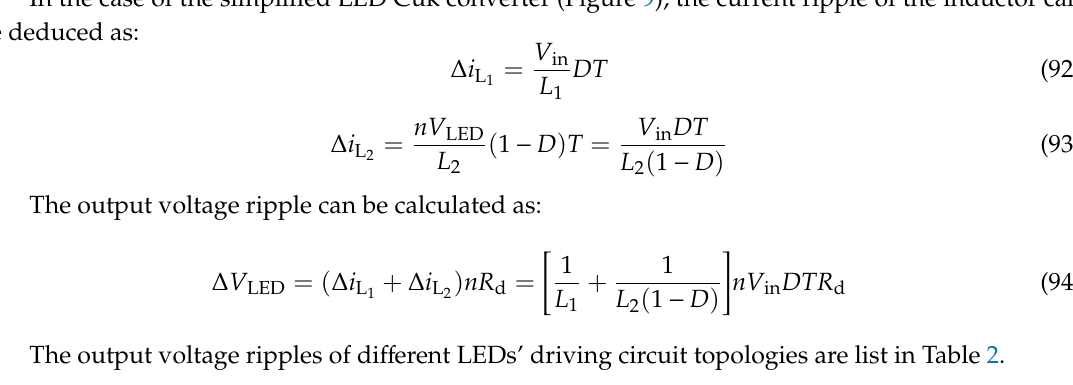
Table 2. Output voltage ripples of di ff erent LEDs’ driving circuit topologies.